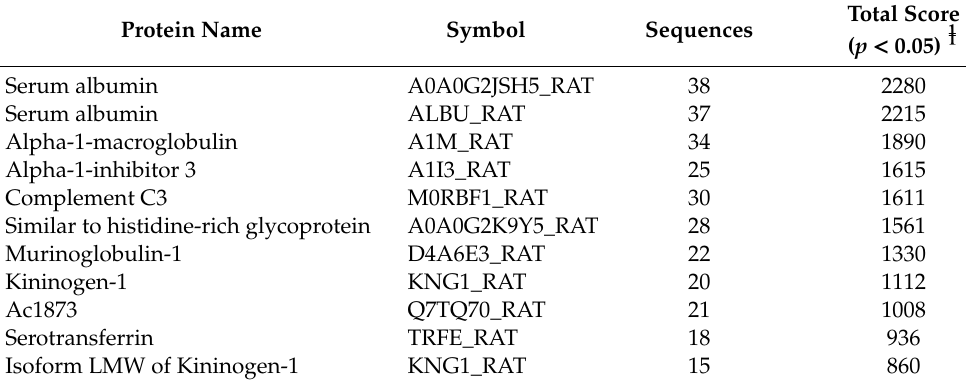
Figure 6. Kyoto encyclopedia of genes and genomes (KEGG) pathways for deiminated proteins identified in plasma of sham and pre-motor PD model rats. ( A ) KEGG pathways identified in circulating EVs of sham-treated (control) rat plasma are highlighted. Colour codes for nodes included in the figure. ( B ) KEGG pathways identified for deiminated proteins in circulating EVs of pre-motor PD model rat plasma are highlighted; notably pathways for PD and other neurodegenerative disease are identified for deiminated proteins in the pre-motor PD plasma-EVs. See colour codes for nodes and for connecting lines in the figure. Table 1. Deiminated proteins in sham-treated rat plasma ( Rattus norvegicus ), as identified by F95-enrichment and liquid chromatography mass spectrometry (LC-MS / MS) analysis. Deiminated proteins were isolated from sham-treated rat plasma by immunoprecipitation using the pan-deimination F95 antibody. The resulting F95-enriched eluate was then analysed by LC-MS / MS and peak list files submitted to mascot. Rattus norvegicus species-specific peptide sequence hits are listed, showing number of sequences for protein hits and total score. Blue highlighted rows indicate protein hits identified in whole plasma of sham-treated rats, but not identified as deiminated in plasma of the pre-motor PD